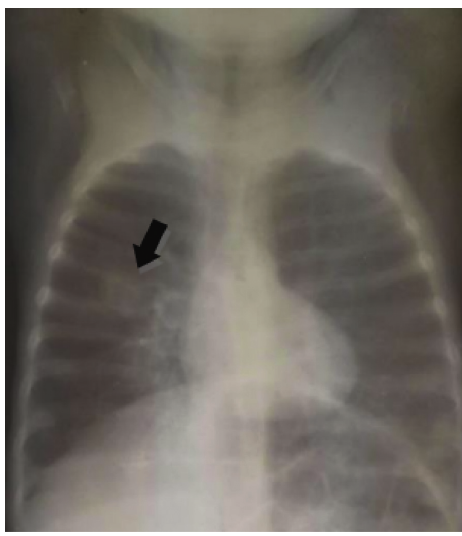
Figure 1: Pneumonia in the right